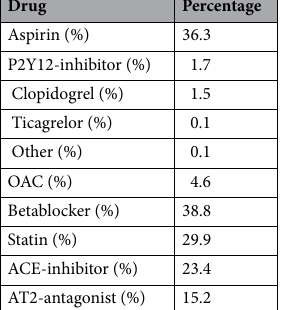
Table 2. Medication on admission among 1379 patients discharged after hospitalization for AC. OAC oral anticoagulation, ACE angiotensin converting enzyme, AT2 angiotensin 2.